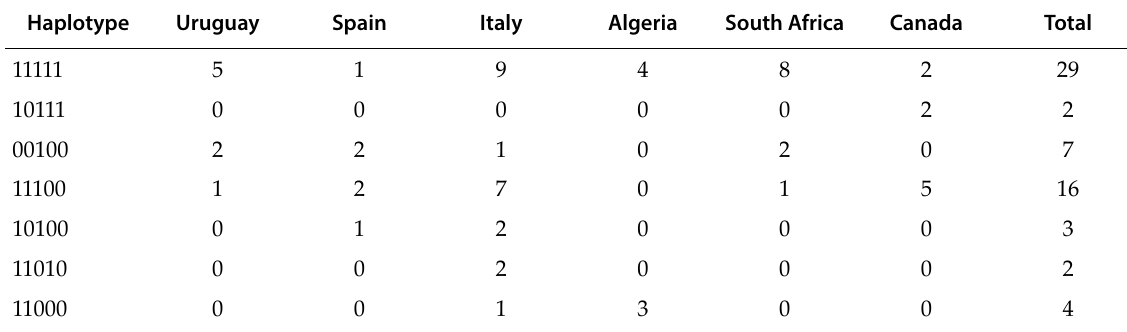
Table 3. Distribution of haplotypes of Togninia minima in samples from six countries. Haplotype Uruguay Spain Italy Algeria South Africa Canada